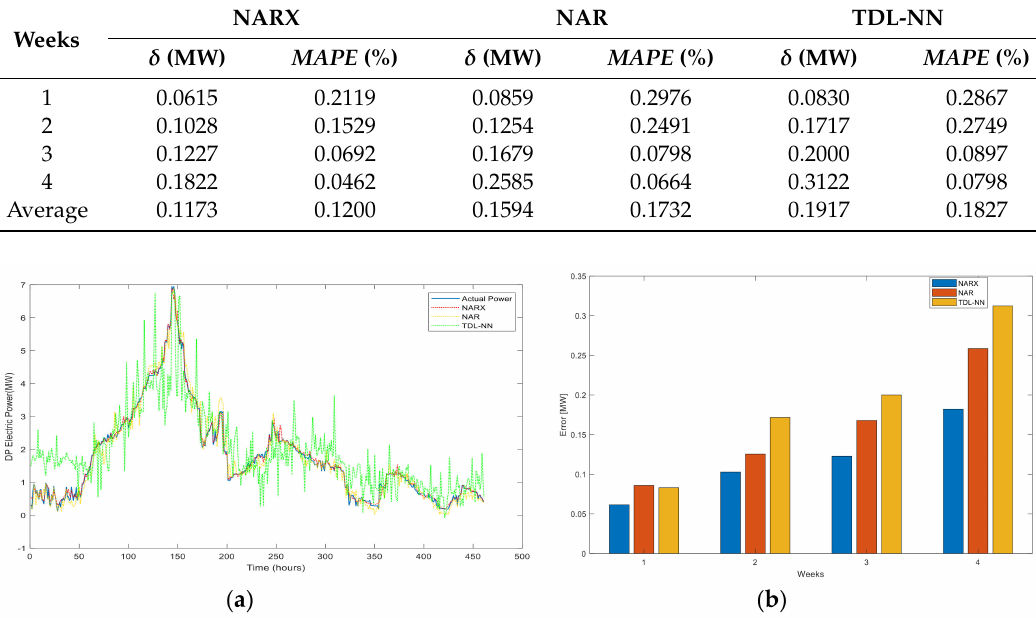
Figure 11. ( a ) The proposed method comparison for SOTLF for two weeks ahead forecasting error percentage, and ( b ) error variance in MW for weeks in a